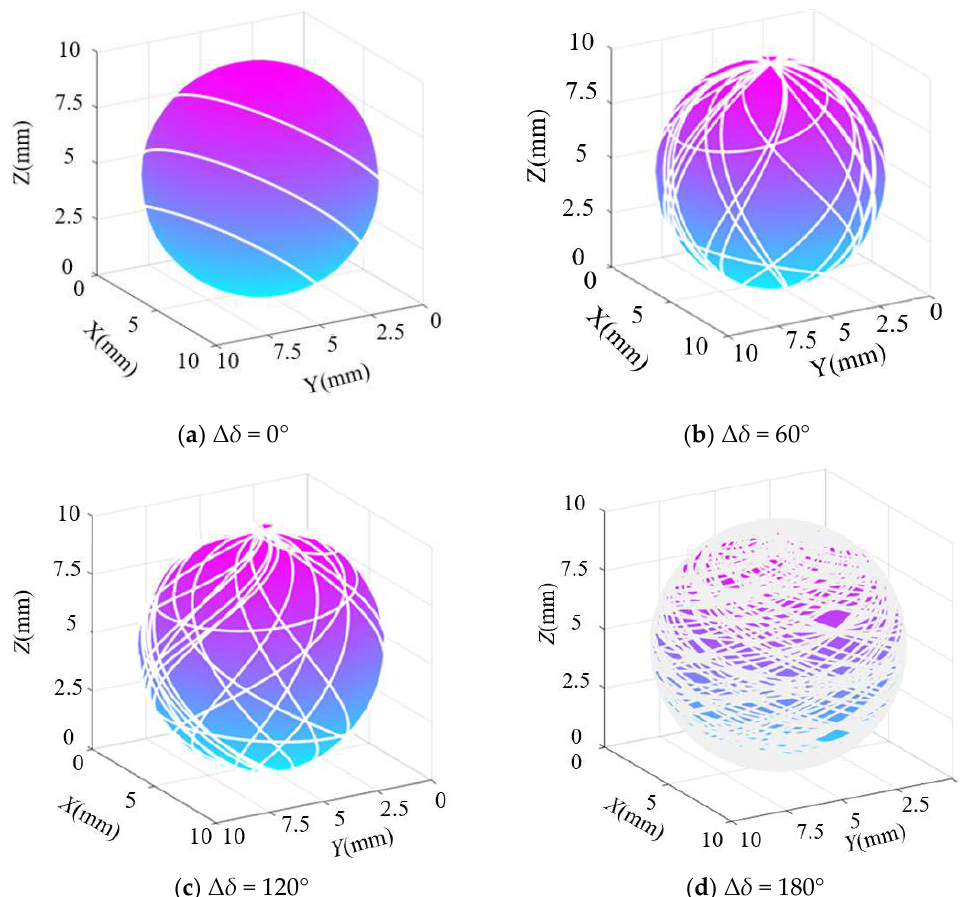
Figure 3. Lapping trajectory of sphere surface under different rotation angle variation.